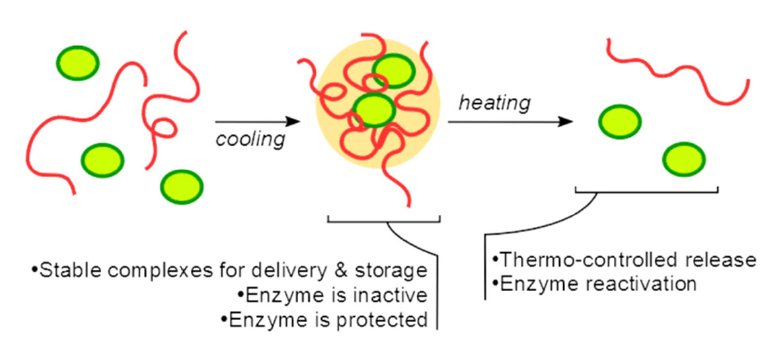
Figure 9. A schematic representation of an enzyme delivery system based on PNAGA [79]. Repro- duced with permission from P. I. Semenyuk et al., Polymers; published by MDPI,